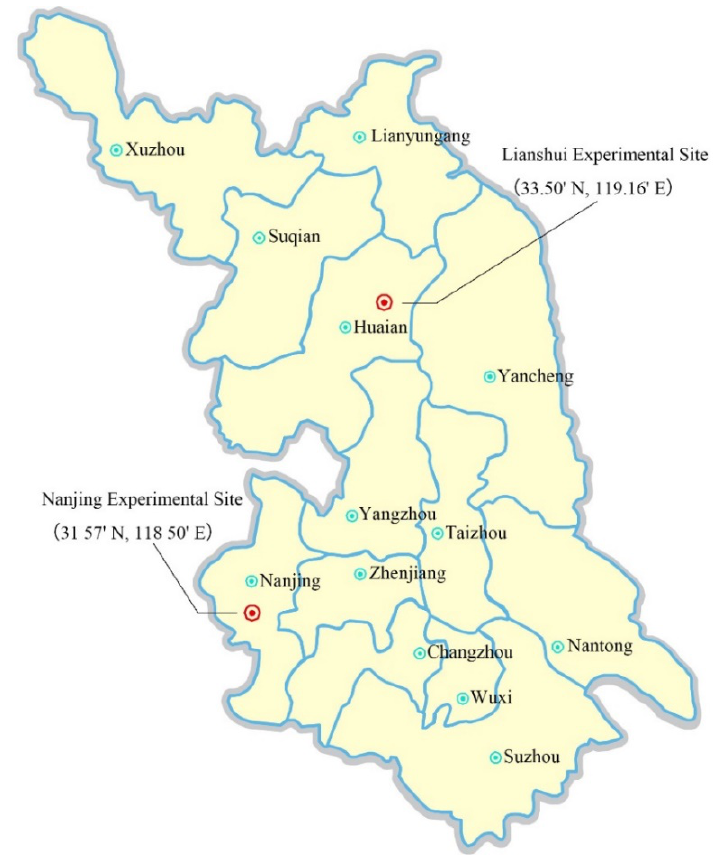
Figure 1. Location of experimental sites in the map of Jiangsu province, China.